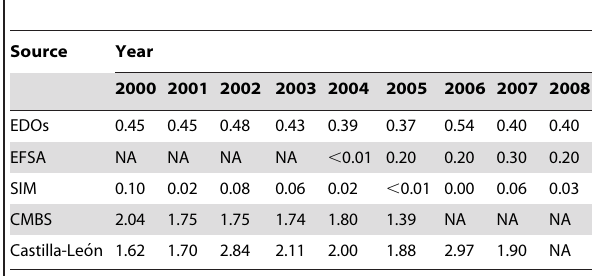
Table 2. Reported cases per 100,000 inhabitants of cystic echinococcosis in Spain from 2000 to